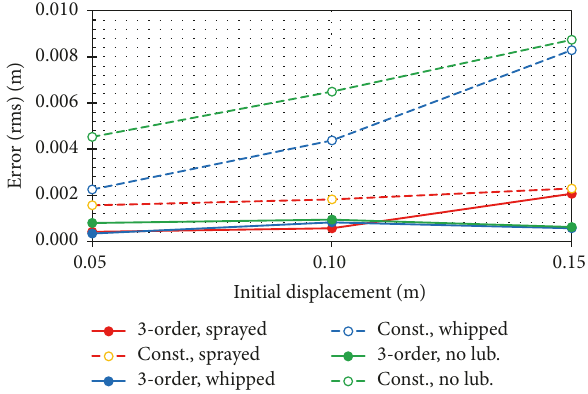
Figure 20: The comparison of RMS displacement errors for simu- lation results with cubic polynomial friction function and constant friction